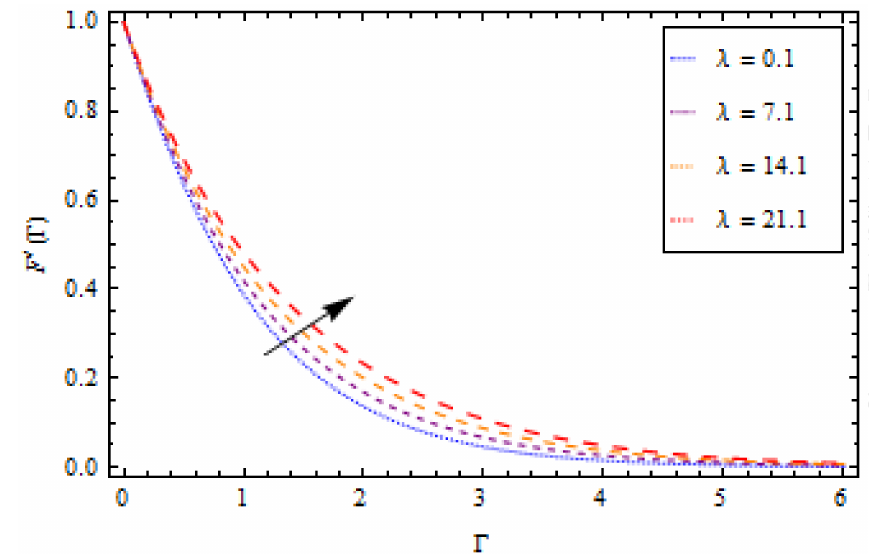
Figure 9. Impact of κ on velocity profile F (cid:48) ( Γ ) , when Pr = 0.5, Rd = 0.5, λ = 0.5, κ = 0.5, γ = 0.5, Sin τ = 1.0, A = 0.5.